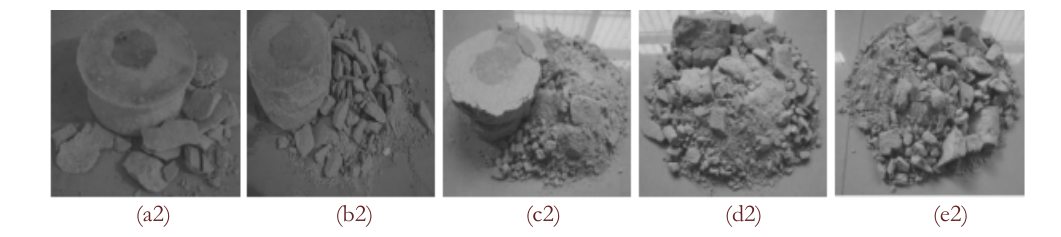
Figure 2: Damage form of sandstone samples